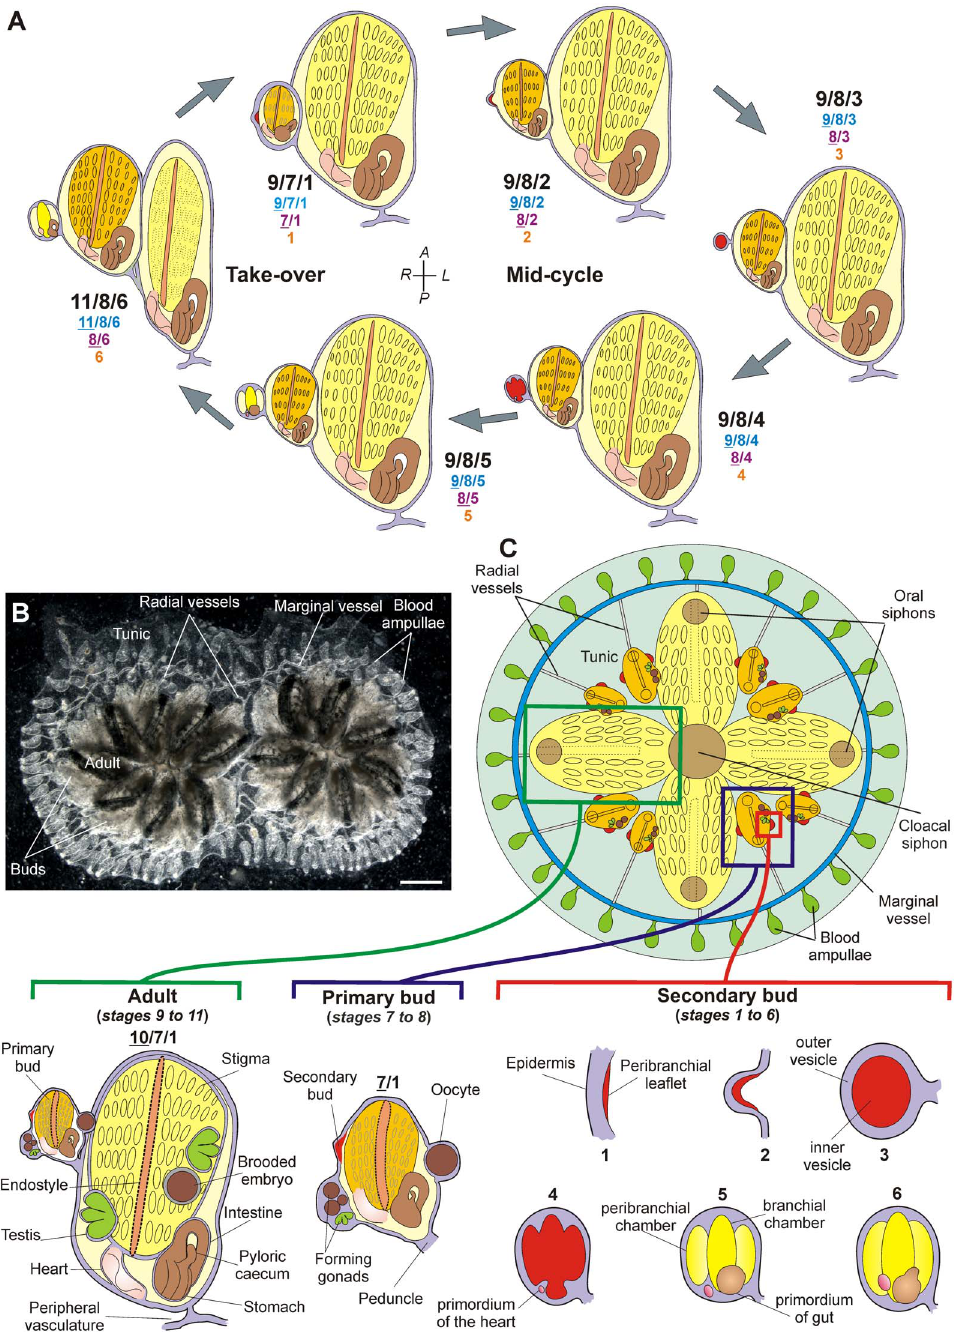
Figure 3. Blastogenetic cycle of B.schlosseri . A . Scheme showing the colonial cycle and the corresponding stages of blastozooid development (sketched in ventral view, irrespective of the true reciprocal per-lateral orientation between the three generations). Colony stages are indicated by a combination of three numbers separated by slashes (black); stages of blastozooids of first, second and third generation are indicated in blue, purple and orange, respectively. The blastozooid begins its life as a small secondary bud at stage 1, becomes a primary bud passing from stage 6 to 7/1, and adult passing from stage 8/6 to 9/7/1. Its regression occurs at stage 11/8/6. The take-over represents the colonial phase in which changes of generation occurs. In blastozooids, anterior at top and posterior at bottom (modified from [40]). B. Ventral view of a colony of B. schlosseri , constituted of two systems. Scale bar: 1 mm. C. Scheme of a system (dorsal view) and details of its blastozooids (ventral view). In blastozooids, anterior at top, posterior at bottom and irrespective of the true reciprocal per-lateral orientation between the three generations (modified from [5]).